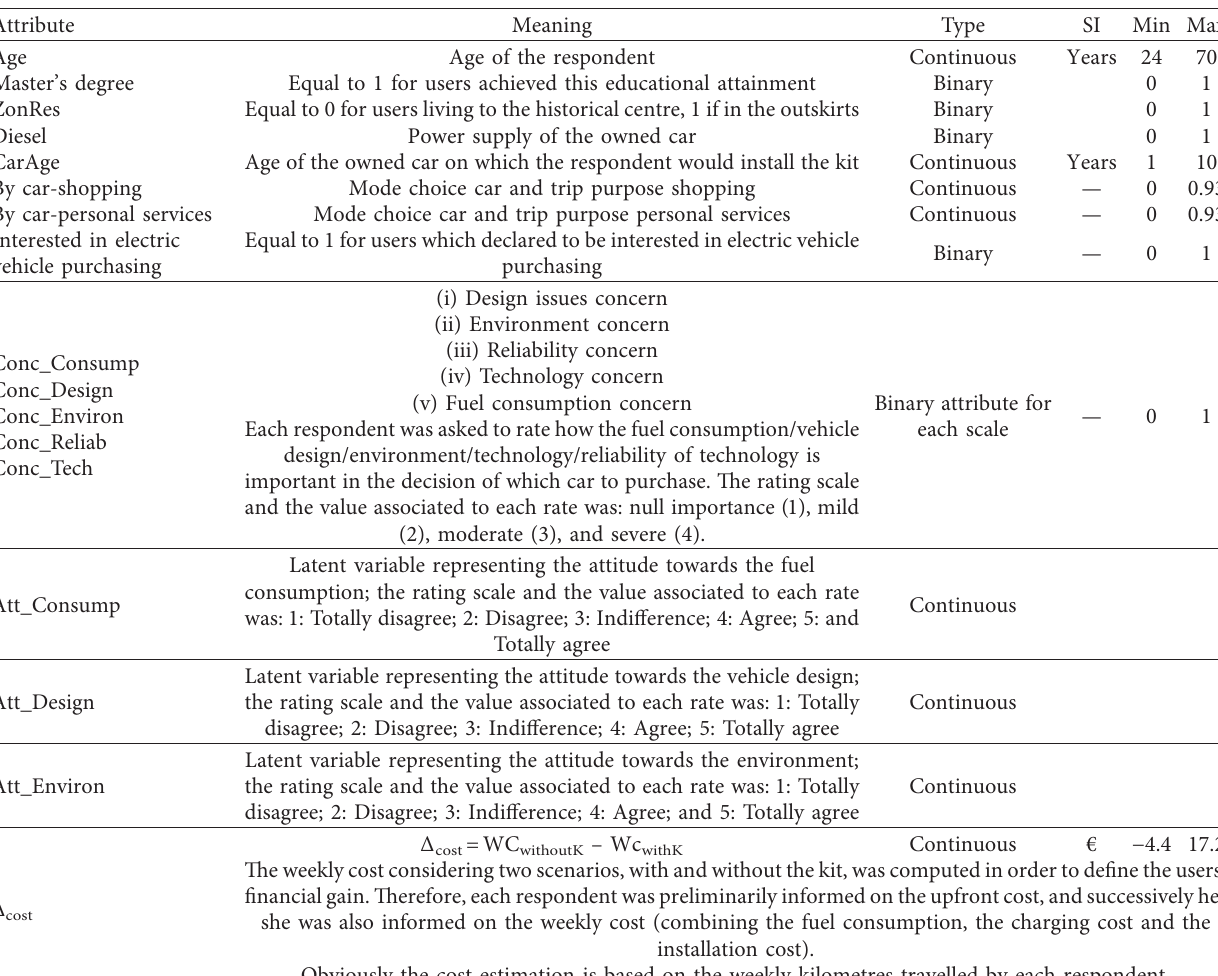
Table 4: Collected and investigated attributes.